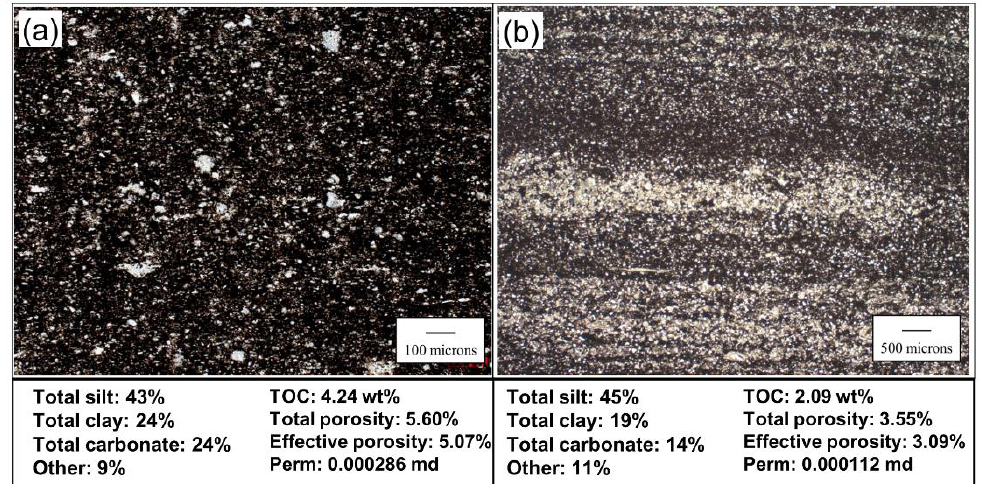
Figure 4. ( a , b ) Mineralogy features of two representative thin sections.